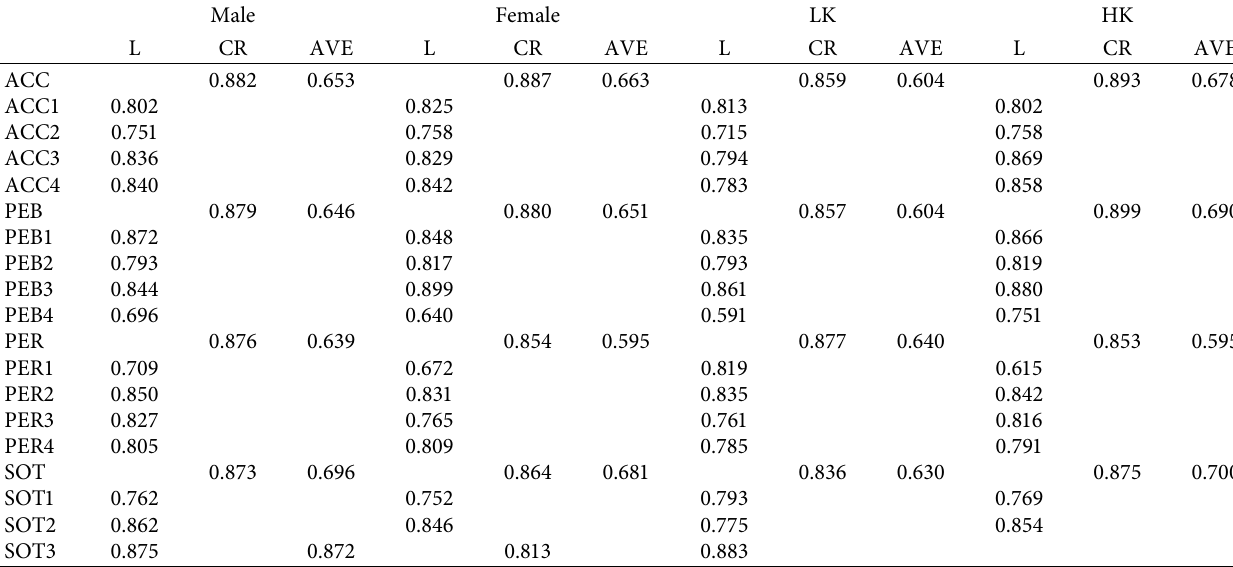
Table 8: Factor loadings, composite reliability, and average variance extracted (subgroup).